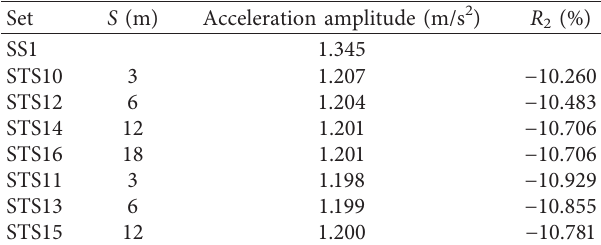
Table 5: Acceleration at the top of the interior